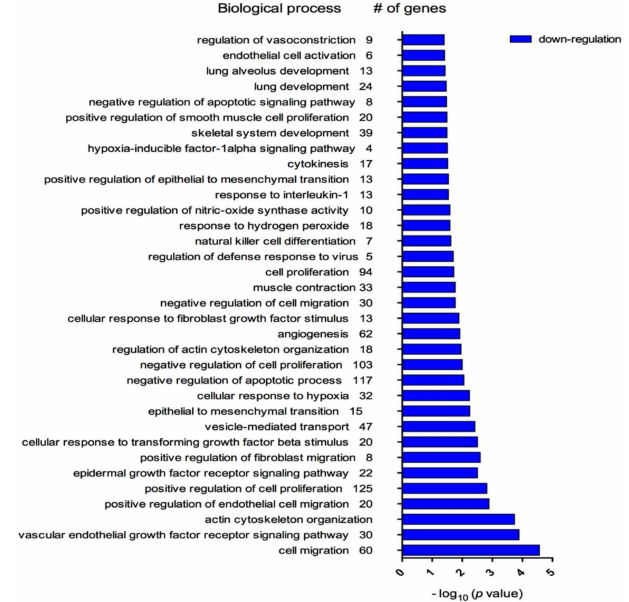
Figure 3. Biological processes, obtained by database for annotation, visualization, and integrated discovery (DAVID) analysis, associated with target genes of striated muscle-specific microRNAs from plasma-derived extracellular vesicles characterizing patients with chronic obstructive pulmonary disease (COPD), group